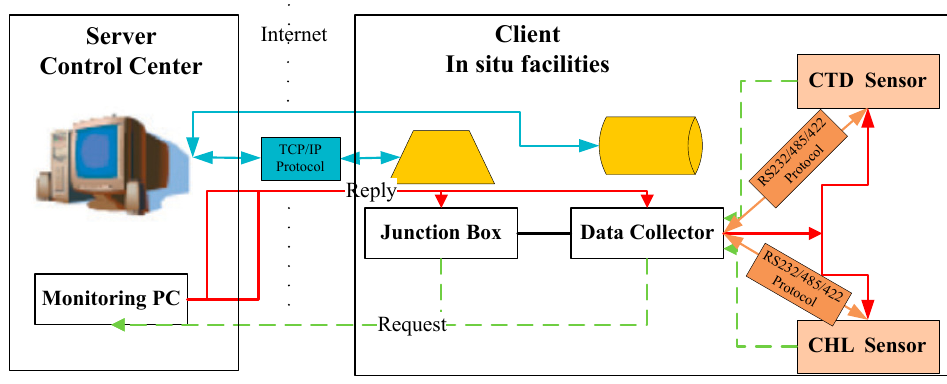
Figure 2. The C/S architecture and remote communication of